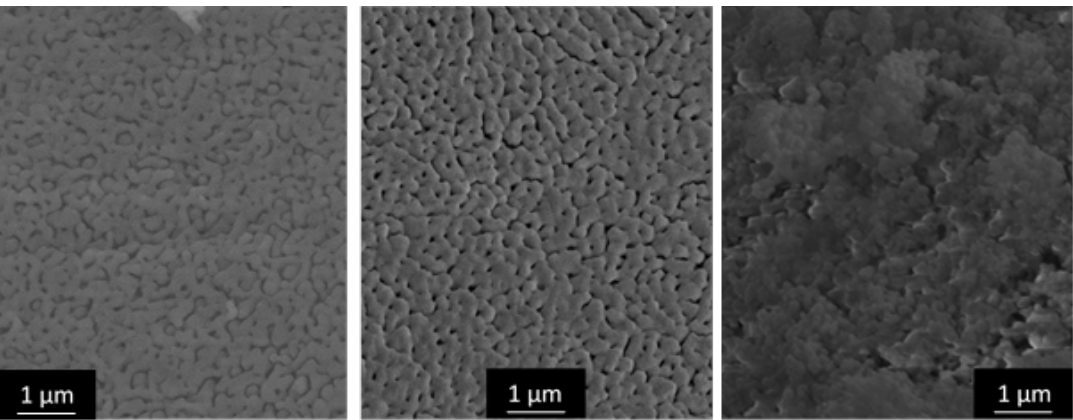
Figure 10. Comparison of SEM images of samples MCH-w (left), MCH-o (center), and SG-Ref0-(80) (right, epoxide-mediated), all calcined at 1200 °C, illustrate the increased pore volume obtained via mutual cross-hydrolysis.